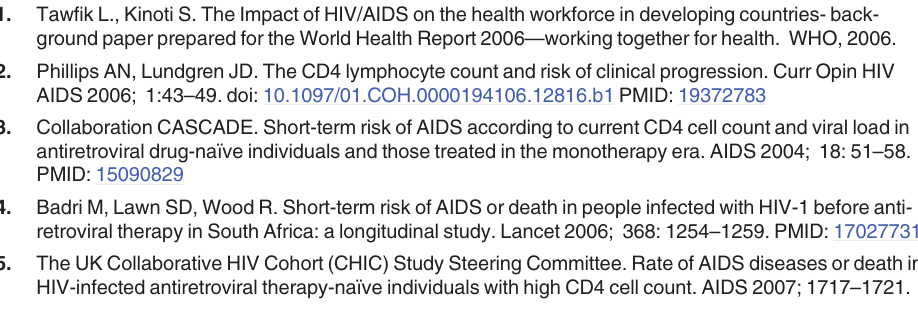
S1 Table. Enrollment characteristics of Phidisa HIV positive participants by protocol en- rollment: mortality cohort. S2 Table. Characteristics of Phidisa HIV positive participants by mortality status: morbidi- ty and mortality cohort. S3 Table. Mortality and Progression of Disease by Latest CD4+ Cell Count by Use of ART: A Comparison between a Cause-Specific Hazard and Competing Risk Proportional Haz- ards Regression